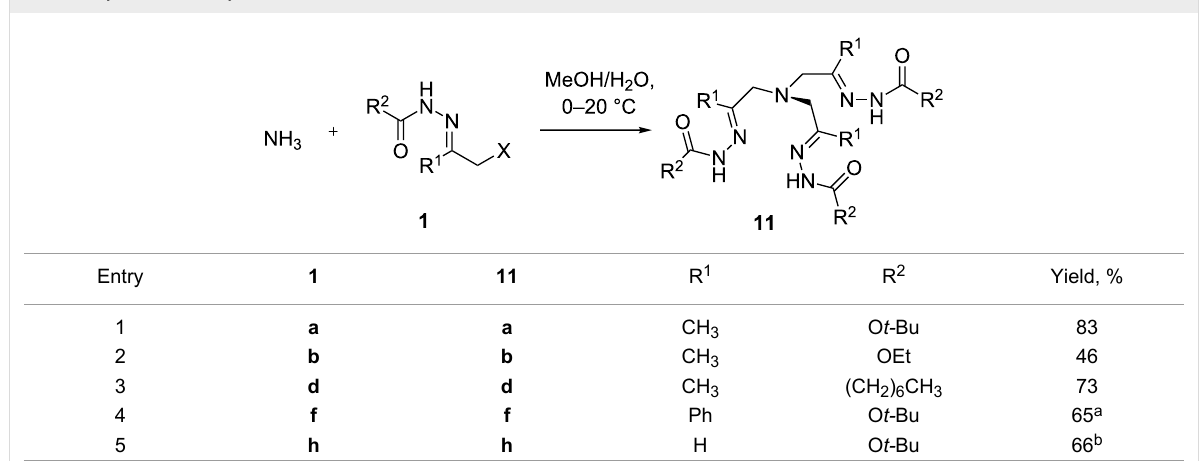
Table 2: Synthesis of trishydrazones 11 .